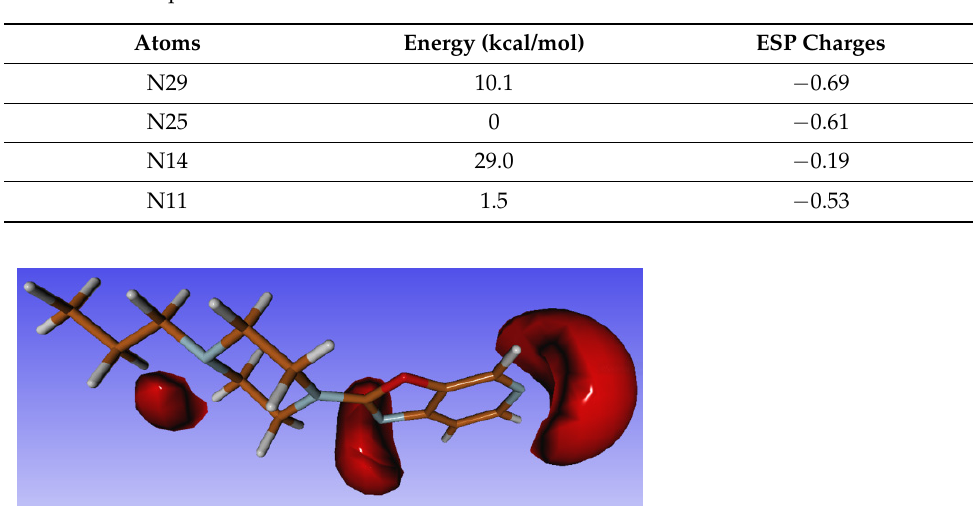
Table 9. Energy of the optimized geometry of molecule 3 in the following different mono-protonated states: at N25, N29 and N11 nitrogen atoms, and CHELPG ESP fitted atomic charges for the optimized molecule 3 in unprotonated state.